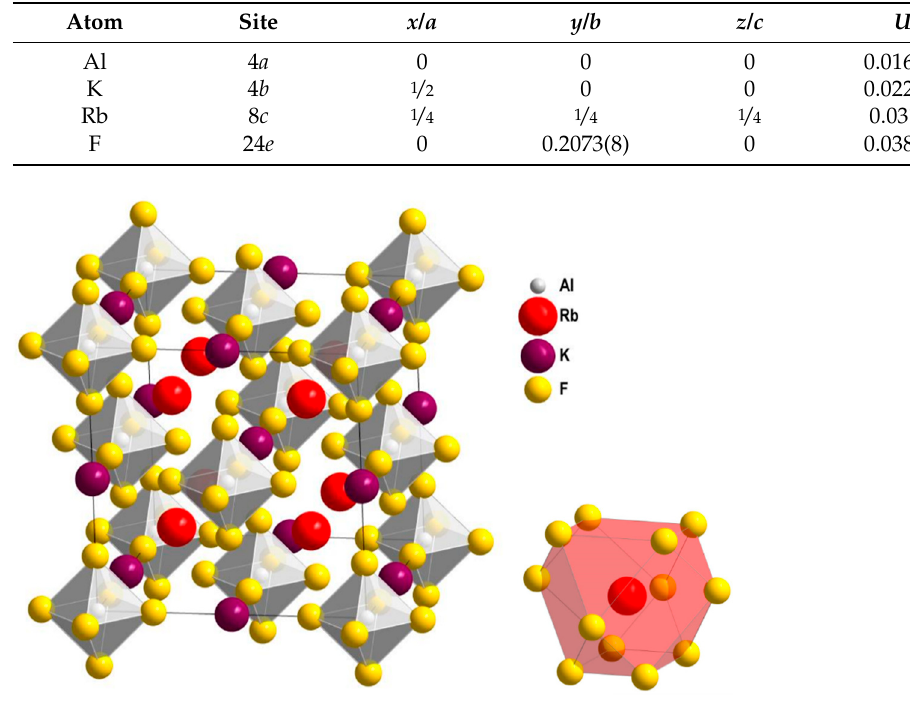
Figure 9. Extended unit cell of Rb 2 KAlF 6 ( left ) and distorted cuboctahedral coordination of rubidium ions ( right ).